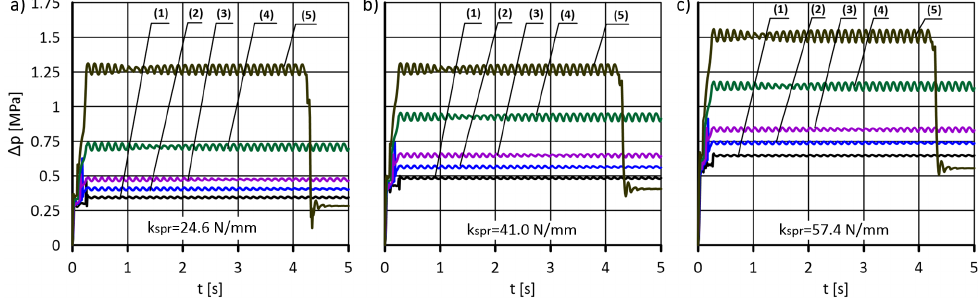
Figure 14. Pressure drop on check valve for different spring rates: ( a ) reduced, ( b ) nominal, ( c ) increased; flow direction A-B.